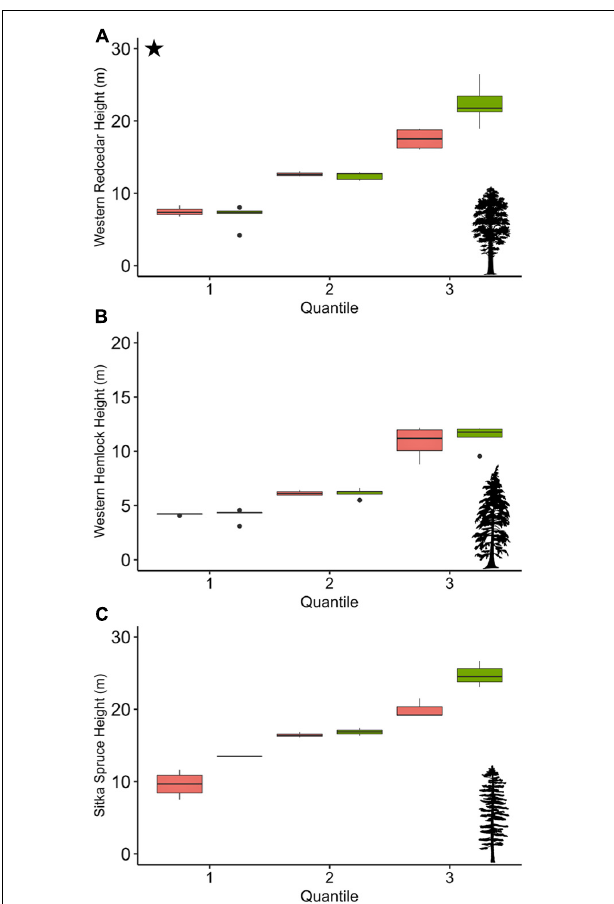
FIGURE 5 | Mean tree height within the control (pink) and habitation (green) sites for (A) western redcedar, (B) western hemlock, and (C) Sitka spruce. All heights were divided into four even density quantiles; however, due to a minimal number of control trees occurring the 4th quantiles, the 3rd and 4th quantiles were combined. * denotes significant treatment effect, determined by Generalized Mixed Model (GLMM) analysis considering treatment, aspect, slope ( Supplementary Table 5 ).